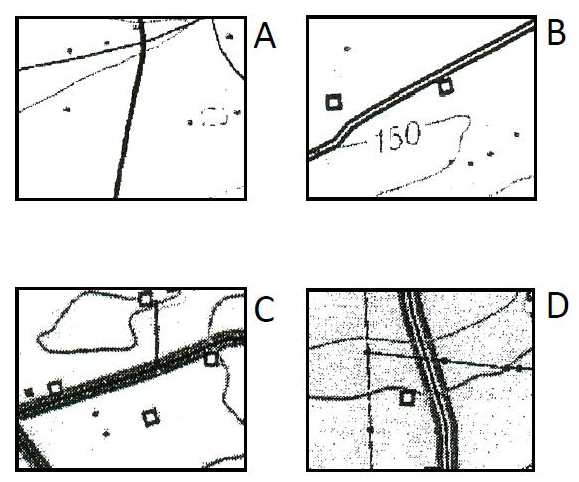
Figure 2. Symbols for roads of different sizes in the Swedish Kartex maps, used as a proxy for traffic intensity. The four categories according to how they appear on the Kartex maps (v. 5.32, The Swedish mapping, cadastral and land registration authority, Lantmäteriet) were: 1 – roads that are reproduced on the map as a straight black line (Fig: 2A). These are small roads not suitable for regular cars. 2 – roads reproduced as two black lines next to each (Fig: 2B). These roads are small with a speed limit of 50 km/h or occasionally of 70 km/h. 3 – roads that are reproduced as a black line with bold lines on the sides (Fig: 2C). Roads with a speed limit from 60 up to 80 km/h, larger country roads. 4 – roads that are reproduced as a black line with two bold lines next to it (Fig: 2D). This includes where the speed limit is 80 km/h or higher, including